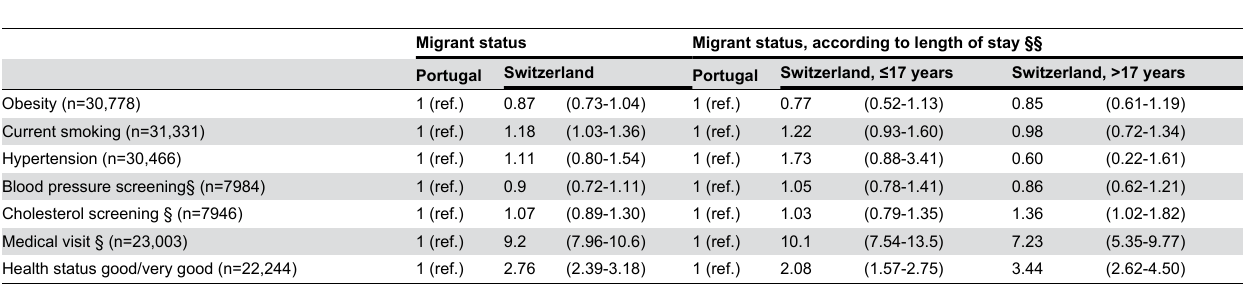
Table 3. Multivariate analysis of the association between migration status and length of stay and cardiovascular risk factors or health care